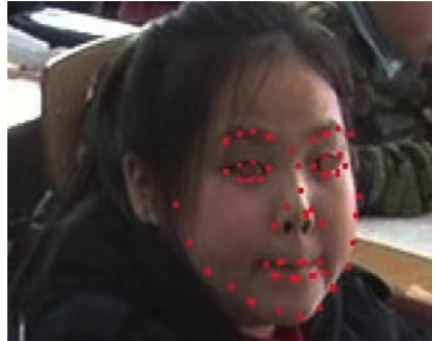
Figure 4: An output example of the landmark